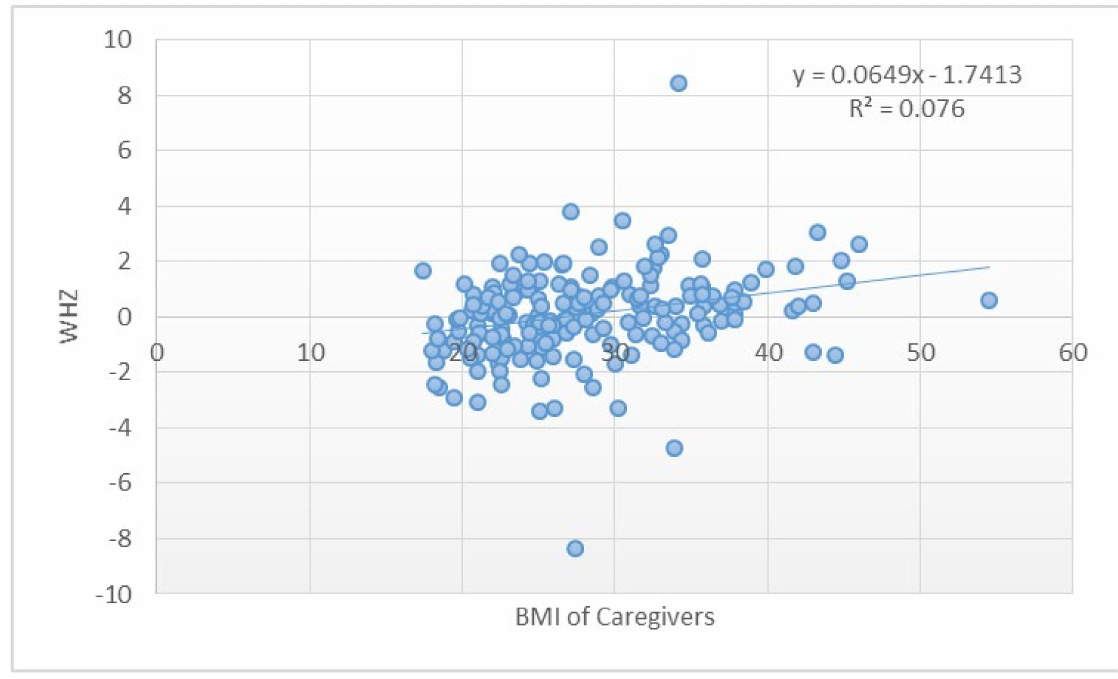
Figure 3. Scatter plot of the WHZ and BMI of